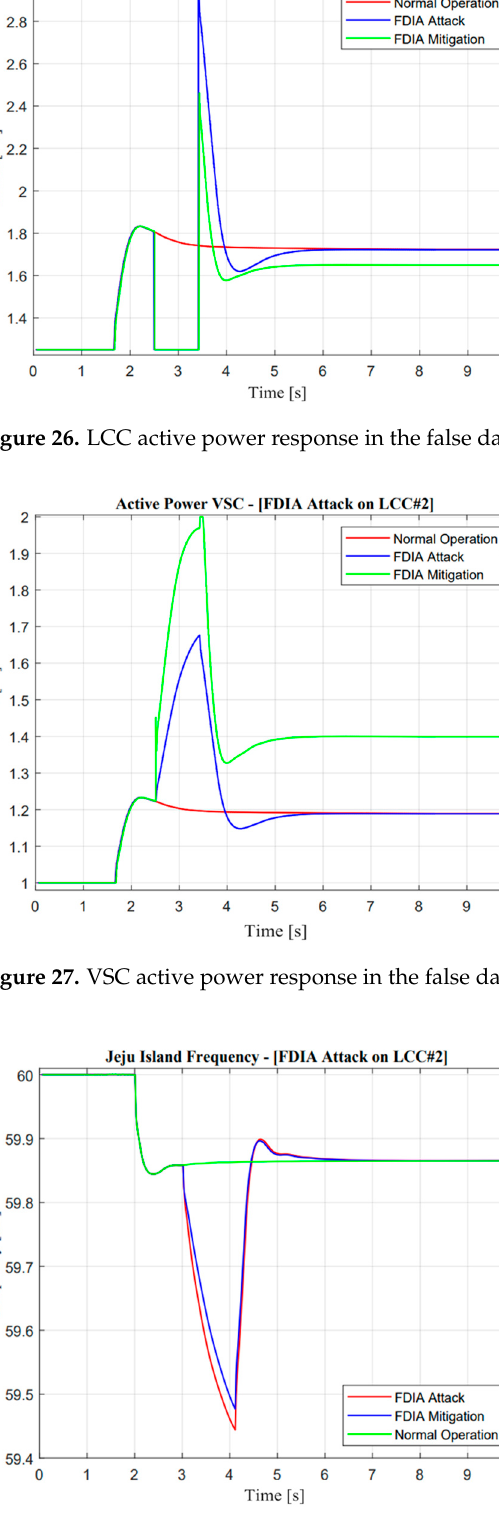
Figure 29. Mainland frequency in the false data injection attack operation. 6. Conclusions The purpose of this article was to examine the security and capacity enhancement of E-FCR control from cyberattacks, particularly DoS and FDI attacks. As a point of vulner- ability for the low-cost and blind data injection attack, we modeled the simplified MIDC system under DoS and FDI attacks. Two different types of DoS attacks were specifically suggested to assess their impact on the three stages of feature frequency responses. The emphasis was on improving the steady-state and frequency nadir contributions in terms of the balancing arrangement along with frequency stability control. Additionally,